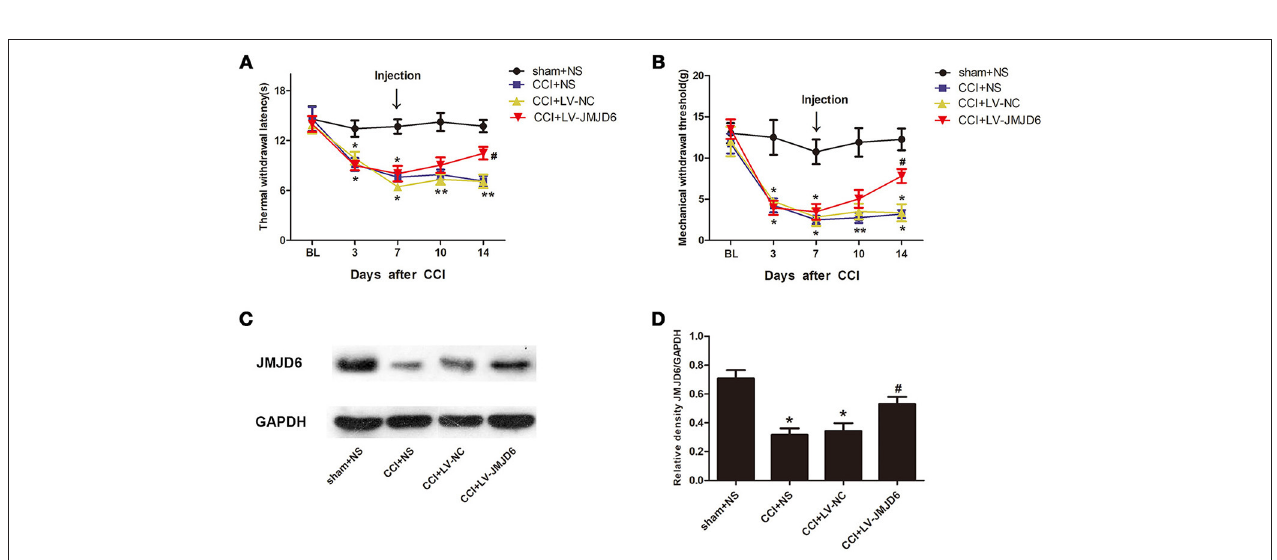
FIGURE 4 | Thermal and mechanical hyperalgesia following CCI is suppressed in rats following intrathecal injection of LV-JMJD6. (A,B) Dynamic changes in TWL and MWT (mean ± SEM, n = 4). (C,D) JMJD6 is increased in the spinal cord after intrathecal injection of LV-JMJD6 in CCI rats ( n = 4). * p < 0.05, CCI + LV-JMJD6 vs. sham + NS group; # p < 0.05, CCI + LV-JMJD6 vs. CCI + NS and CCI + LV-NC groups.